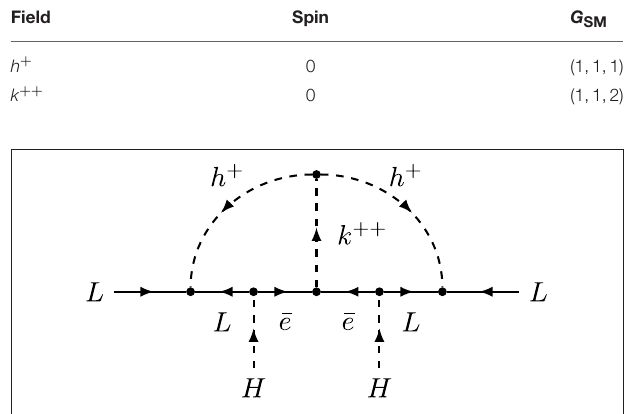
FIGURE 18 | 2-loop neutrino masses generated in the Zee-Babu τ e ) is → τµ ). →